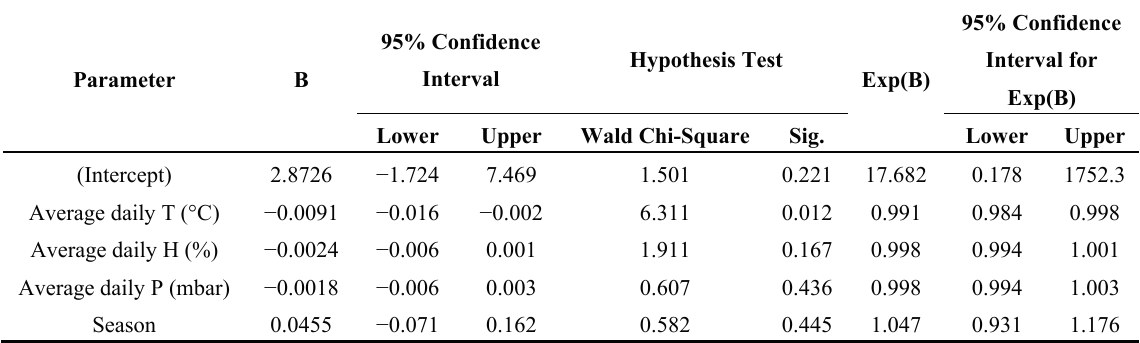
Table 3. Daily ACS incidence for population over than 65